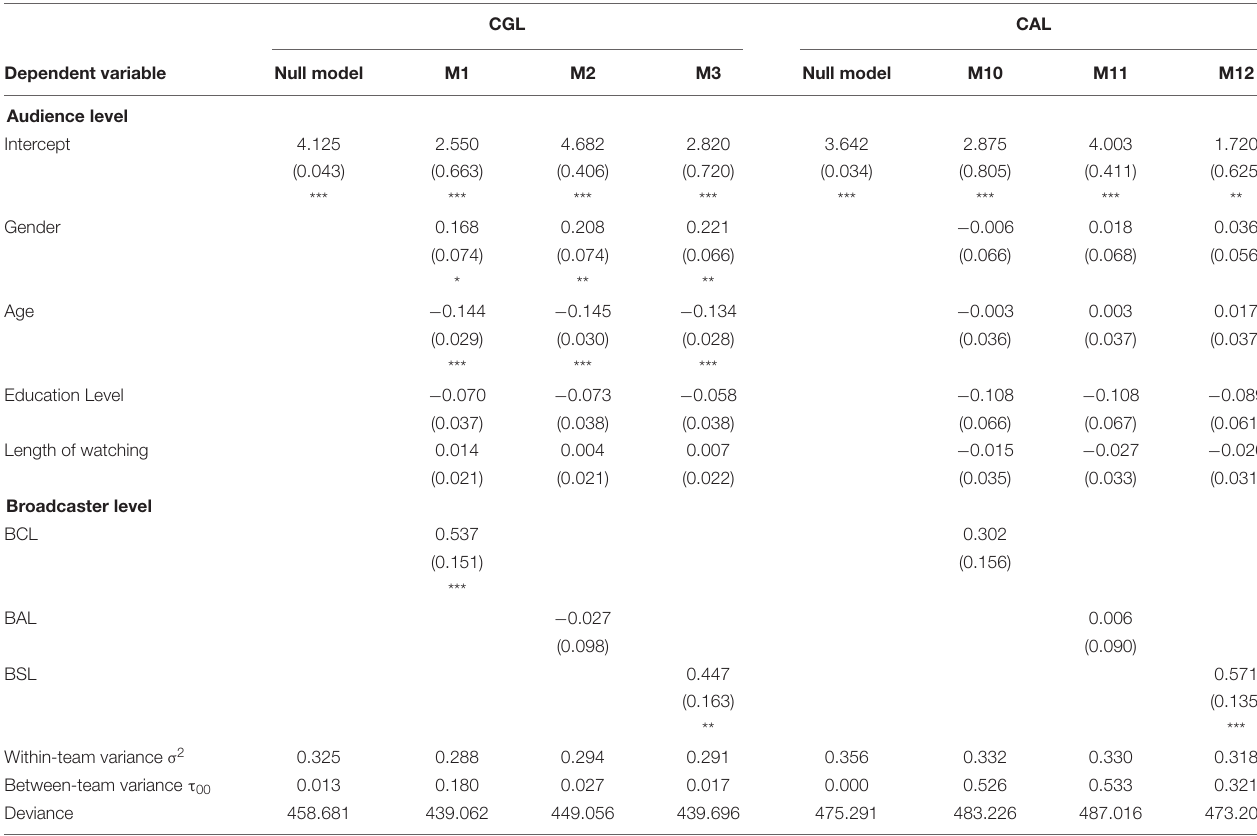
TABLE 5 | The HLM results of broadcaster leadership and